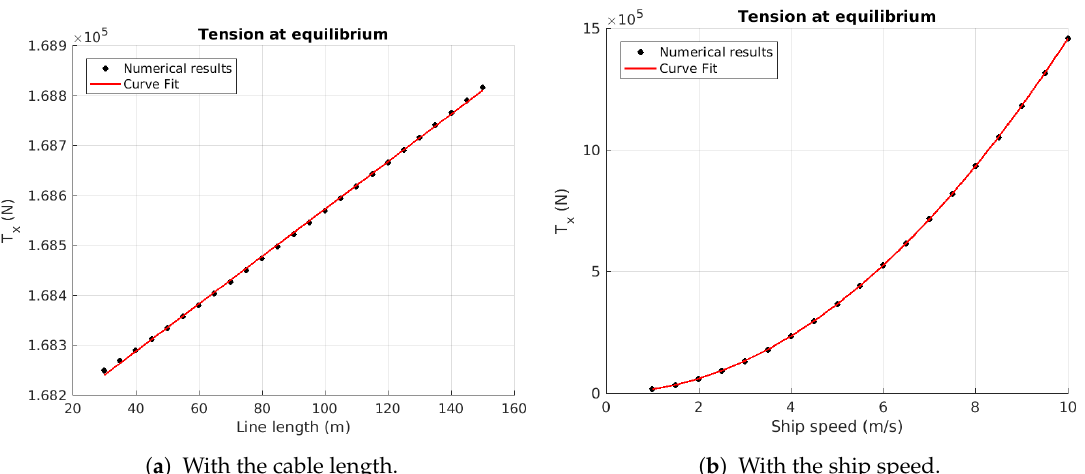
Figure 24. Horizontal tension